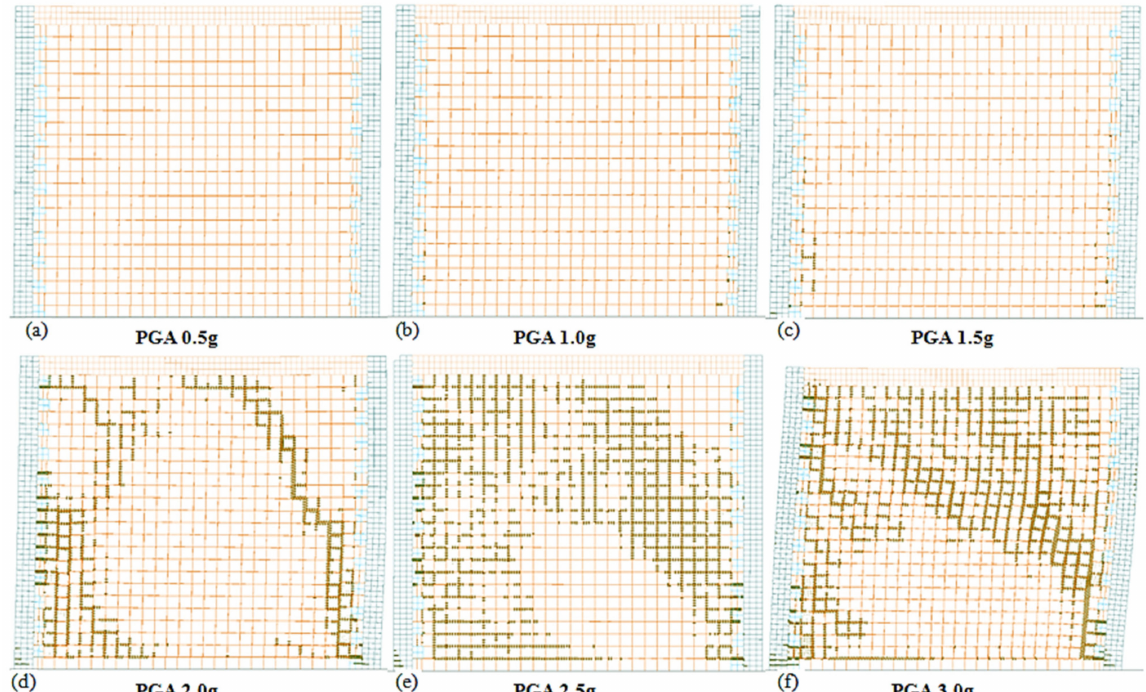
Figure 26. Damage profiles of AEM models for CM wall structure at PGA: ( a ) 0.5 g; ( b ) 1.0 g; ( c ) 1.5 g; ( d ) 2.0 g; ( e ) 2.5 g; ( f ) 3.0